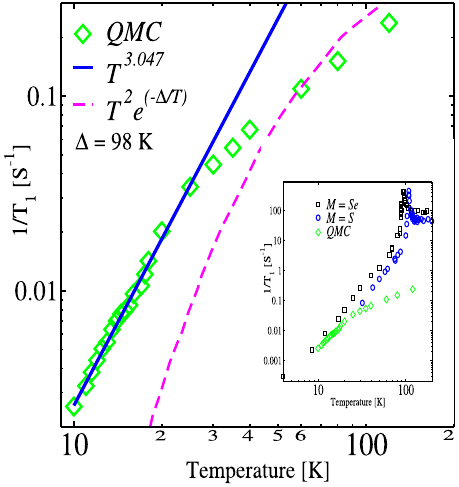
Fig. 7 The nuclear magnetic resonance (NMR) spin relaxation rate (1/ T 1 ). A large-lattice size Quantum Monte Carlo technique was used by employing the Algorithms and Libraries for Physics Simulations (ALPS) to estimate (1/ T 1 ). By doing so, we computed the local transverse spin-spin correlation function for a S = 1 Heisenberg model with geometrical frustration, biquadratic exchange, and single-ion anisotropy as relevant for the Fe-based systems. The QMC results (green squares) were fi tted with T 2 exp ð(cid:2) Δ = T Þ (magenta dashed line) and T 3 (blue line) in the high-T and low-T regions, respectively. The main panel indicates that a 1 = T 1 ’ T 2 exp ð(cid:2) Δ = T Þ form for T > 40 K, with an estimated spin gap of 98 K, smoothly evolves into 1/ T 1 ≃ T 3 for T < 30 K. The low- T power law behavior emerges due to an additional two-magnon relaxation